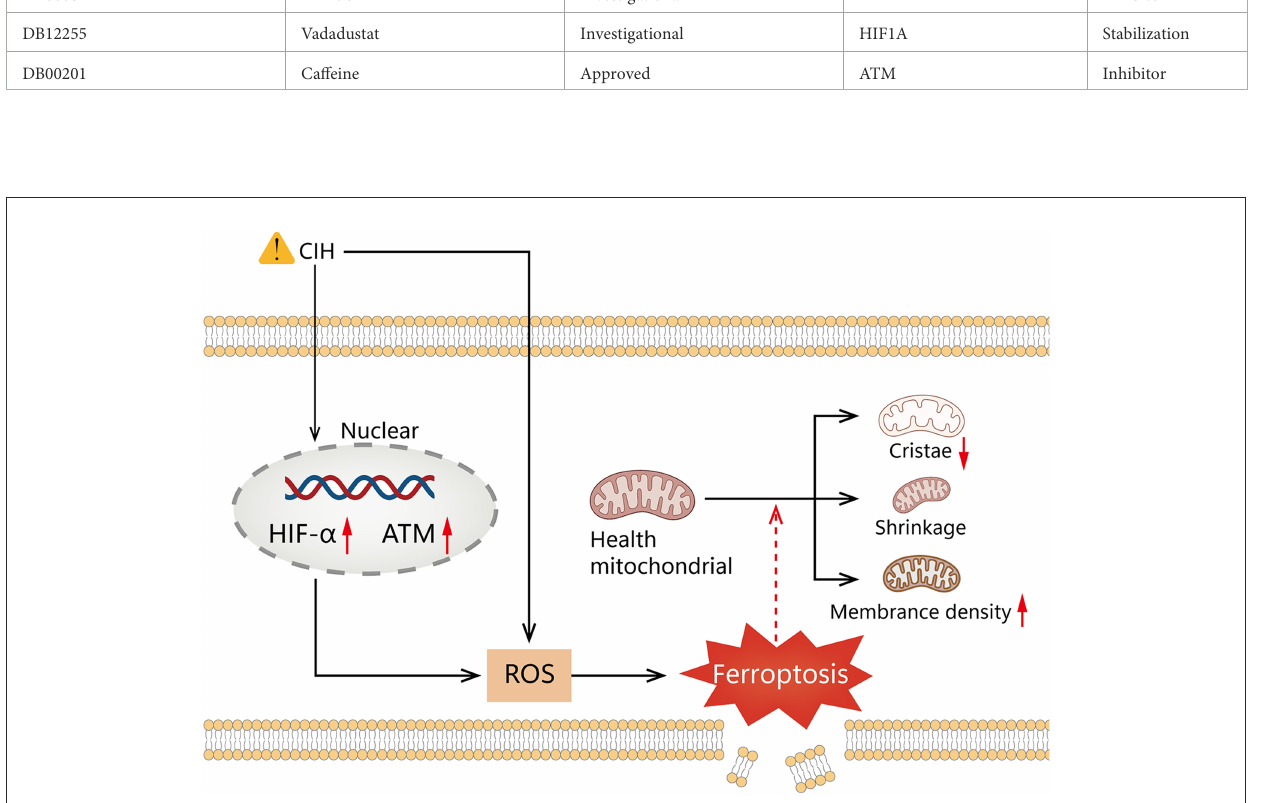
promotes ferroptosis, and contributes to the onset and progression of THCA. Hypoxia causes cervical lymph node metastases